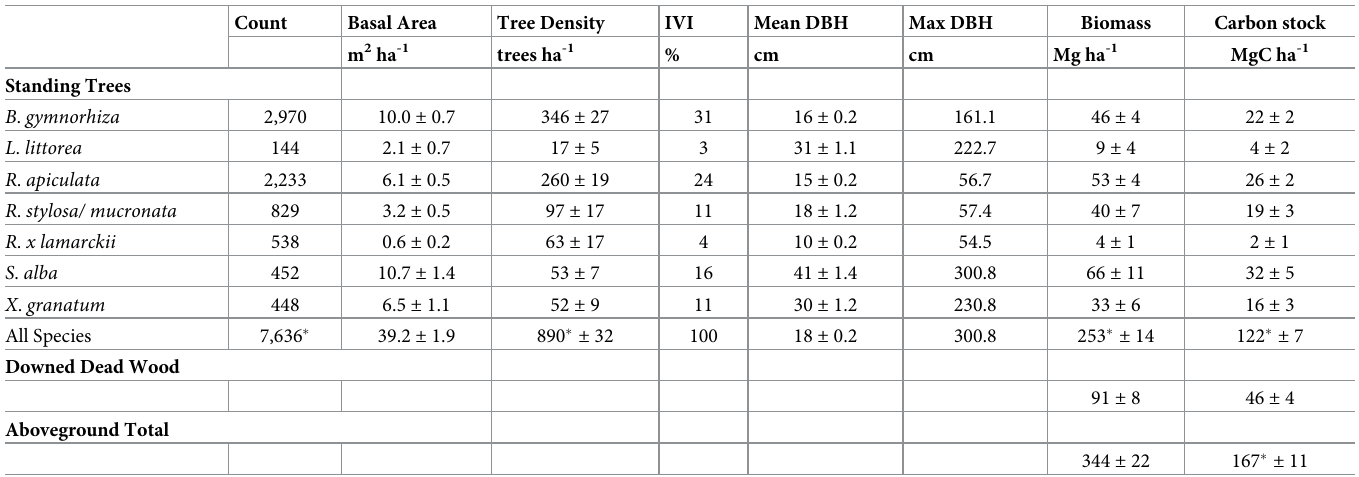
apiculata , and X . granatum with equal parts carbon (Fig 4B). Table 2. Community